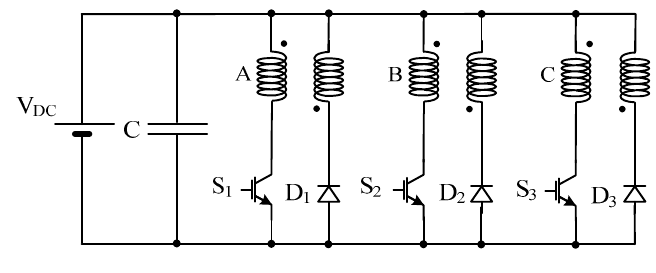
Figure 11. Bifilar topology.